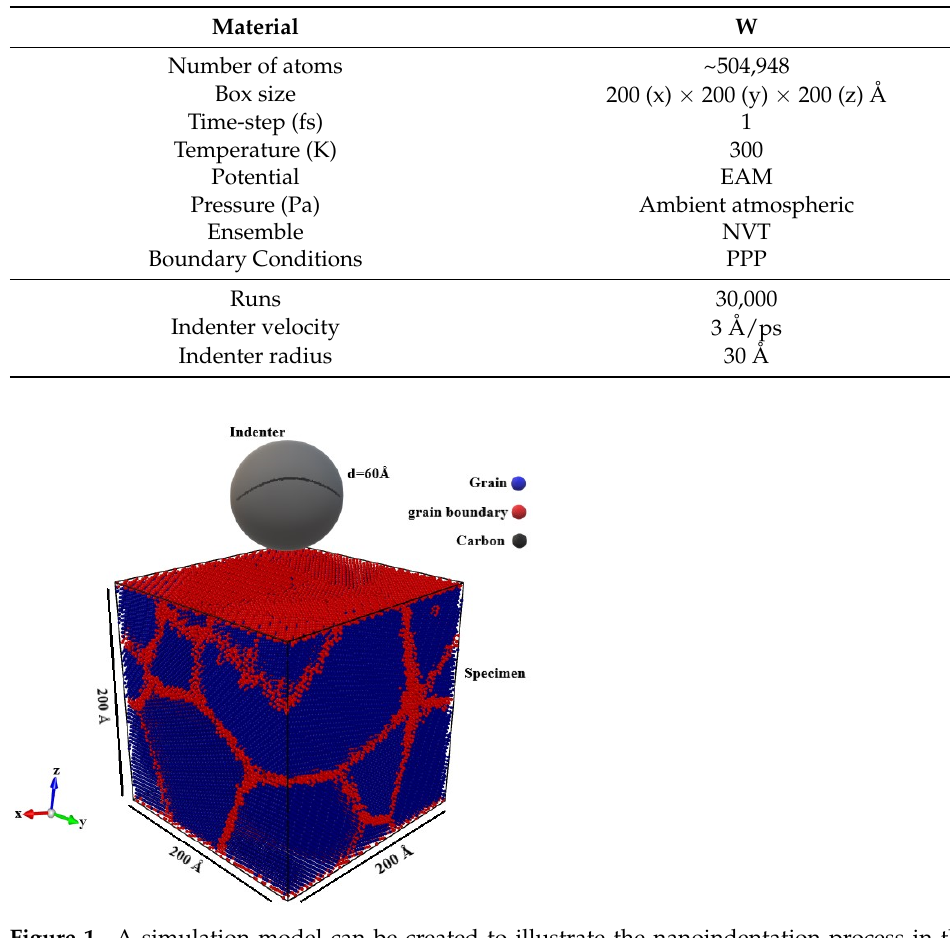
Table 1. Computational details used for the development of the MD simulation model.